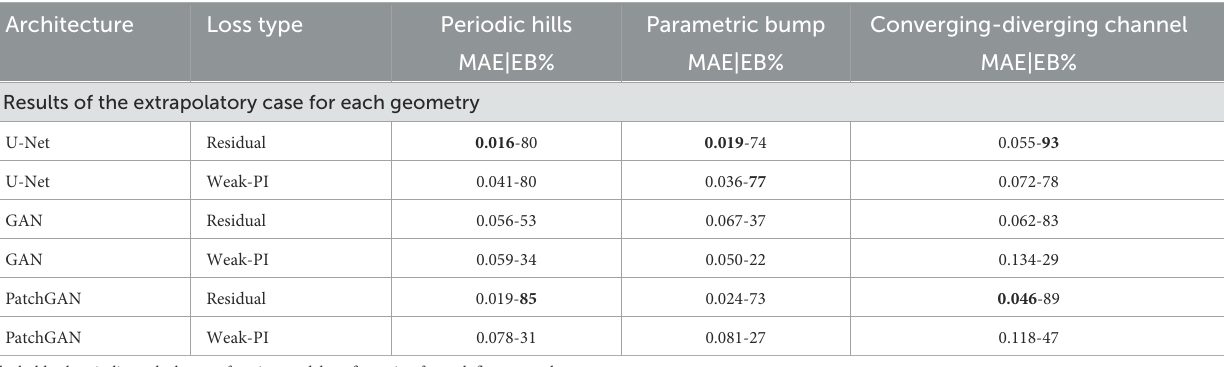
TABLE 3 The root-mean-squared error (RMSE), mean absolute error (MAE), bias, error bound (EB) percentage, and value bound (VB) percentage for the U-net residual model when trained and tested on the multiple-geometry mean flow, sea-surface temperature, and soil moisture datasets. Case